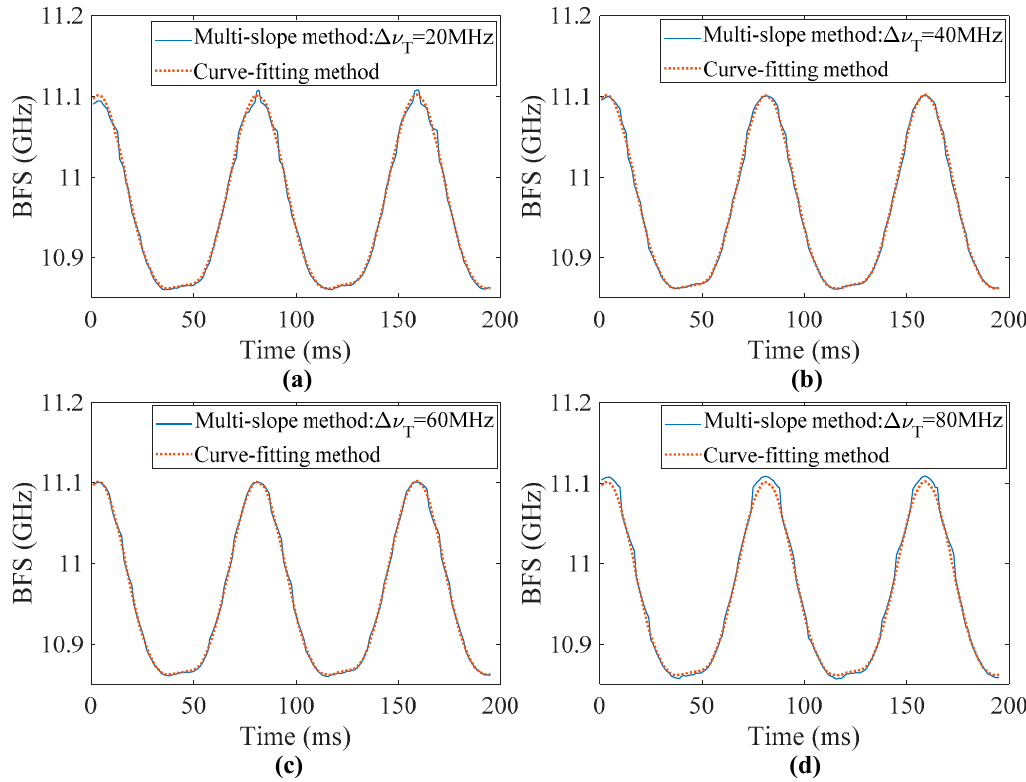
Figure 10. The dynamic measurement of the multi-slope-assisted BOTDA [42] for the frequency intervals of ( a ) 20 MHz, ( b ) 40 MHz, ( c ) 60 MHz, and ( d ) 80 MHz.